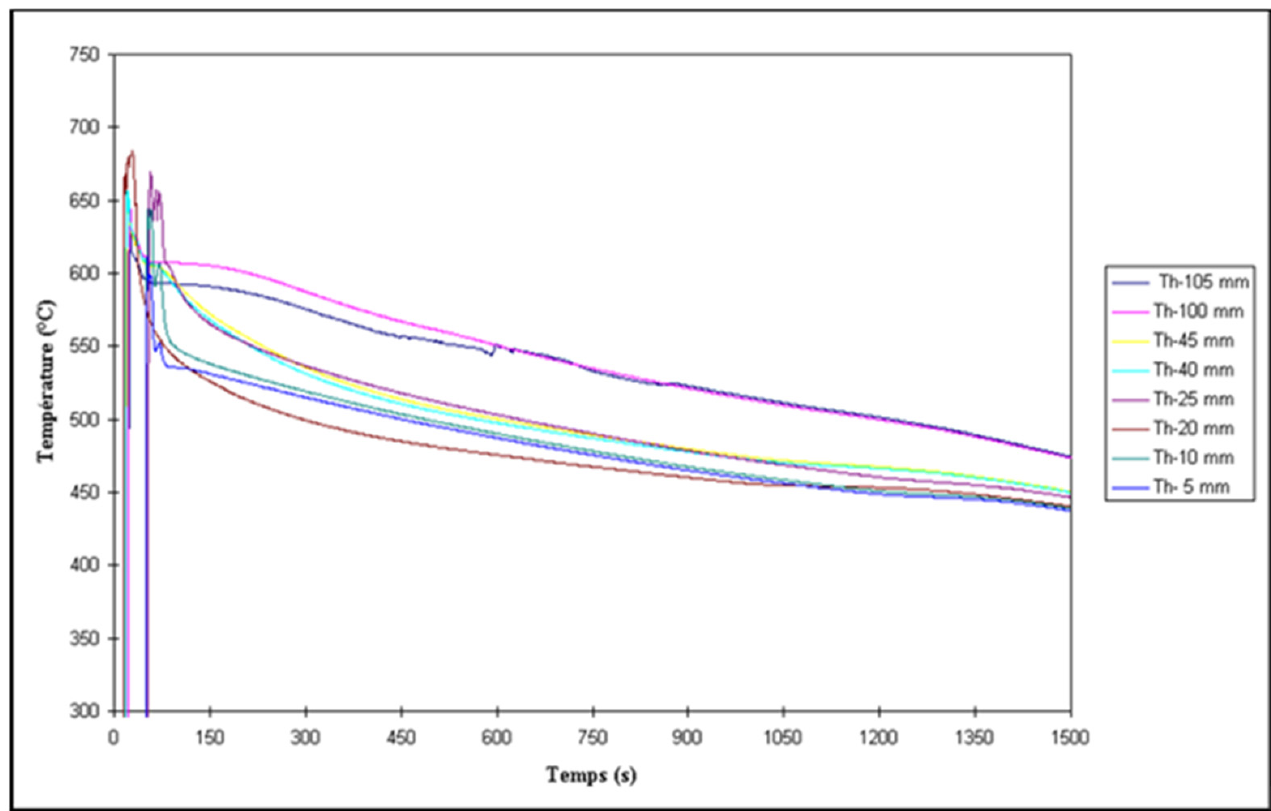
Figure 6. Temperature–time curves obtained at different distance from the chill end. Thermocouples were placed along the centerline of the mold through the refractory block into the cavity.